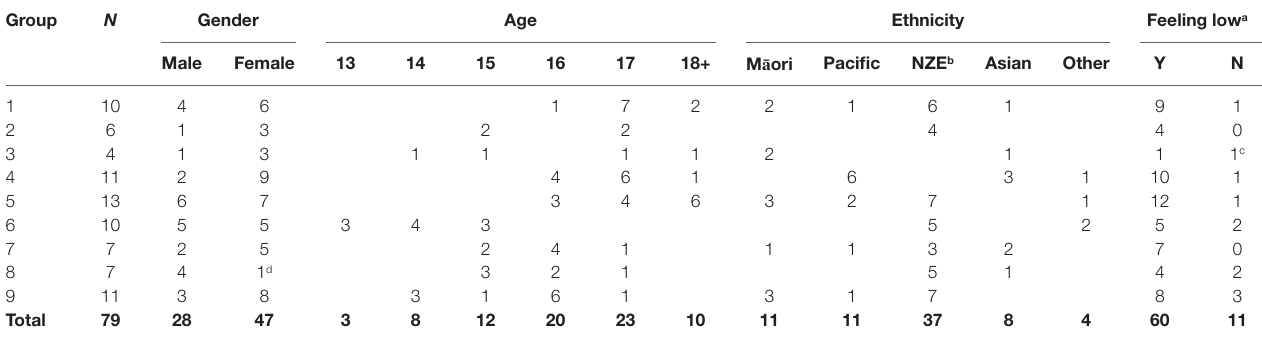
TABle 3 | Participant demographics by focus group.